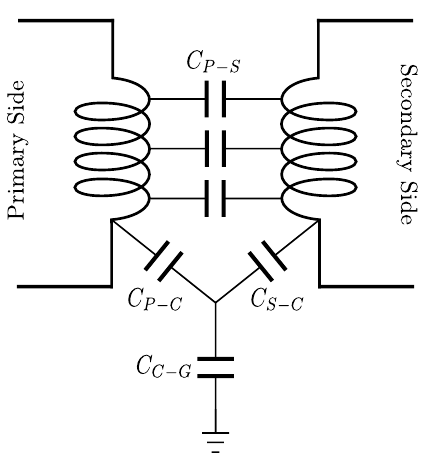
Figure 2. Parasitic capacitance sources in planar transformers. There are four kinds of parasitic capacitances in transformers. Parasitic capacitance between the primary and secondary ( C P − S ), which is between the windings. Parasitic capacitance between the primary side and the core ( C P − C ). Parasitic capacitance between the secondary side and the core ( C S − C ). Parasitic capacitance between the windings/core and the ground ( C C − G